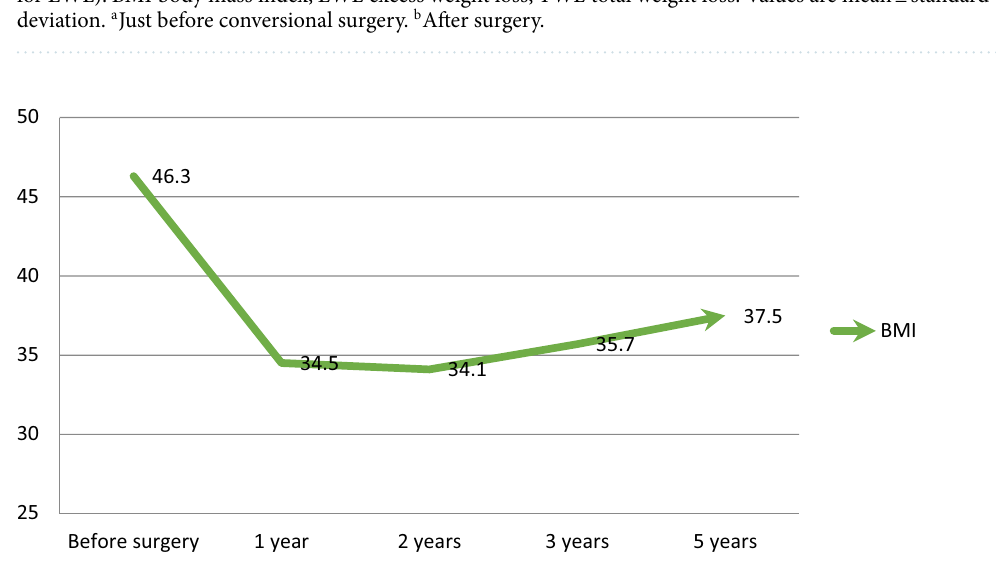
Figure 2. Trend of change in BMI during 5 years after conversional OAGB through repeated measure test. BMI body mass index, CI confidence